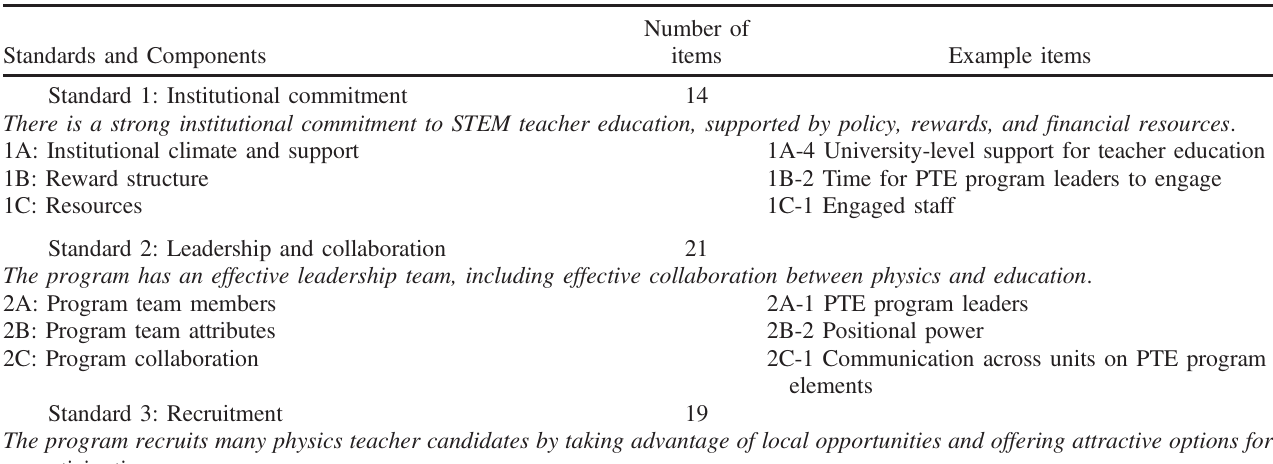
TABLE I. The PTEPA rubric. This shows standards, components, and example items from PTEPA rubric version 2.0 [30]. Alphanumeric code preceding each component (e.g., “ 1A ” ) is the designation of the component number. Standards and